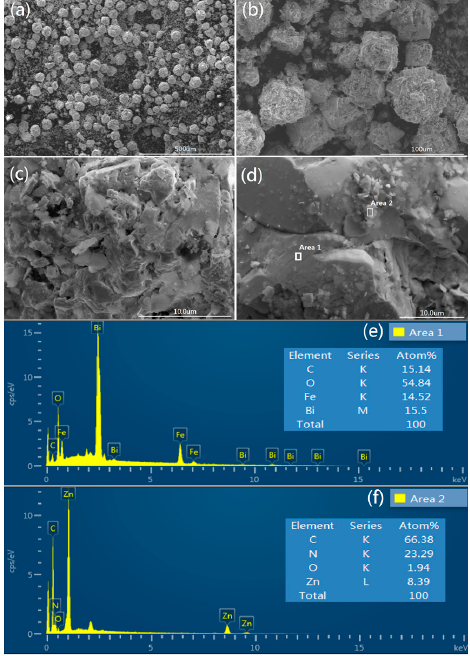
Figure 4. SEM images of ( a ) MOF/BiFeO 3 composite; ( b – d ) the magnification of MOF/BiFeO 3 composite. EDS spectrum of MOF/BiFeO 3 composite, ( e ) Area 1, ( f ) Area 2.